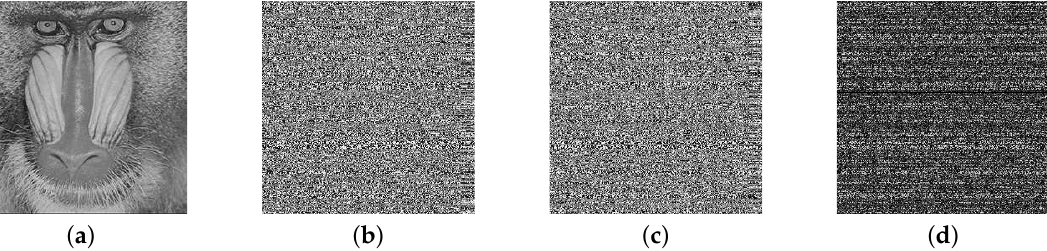
Figure 5. Key sensitivity in the encryption part. ( a ) Plain image of a baboon; ( b ) cipher image by the correct secret key; ( c ) cipher image by the changed secret key; ( d ) information variation between two cipher